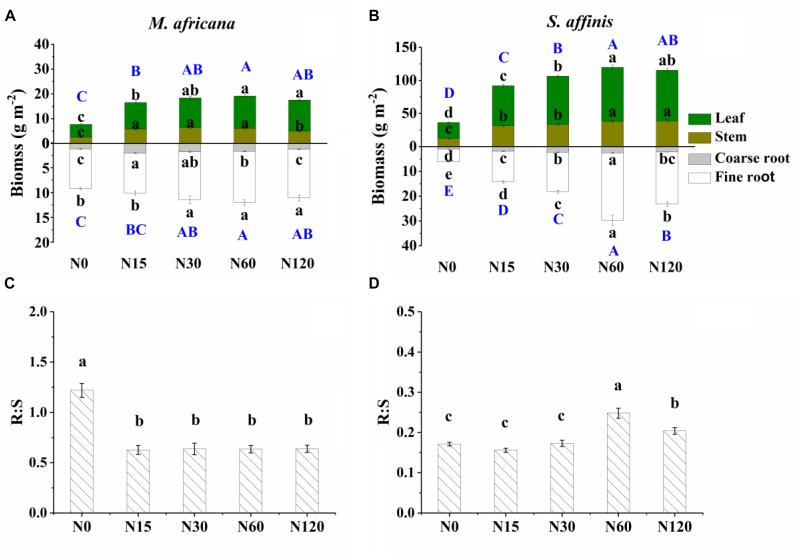
Biomass partitioning (including leaf biomass, shoot biomass, coarse root biomass and fine root biomass) and R:S ratio of M. africana
(A,C) and S. affinis
(B,D) at each N treatment. Bars represent means ± standard error (n = 10). Different lowercase letters above each column show values differ significantly at P = 0.05, and different uppercase letters (with blue color) indicate that the total aboveground biomass (the sum of leaf biomass and shoot biomass) or belowground biomass (the sum of coarse root biomass and fine root biomass) differ significantly at P = 0.05.